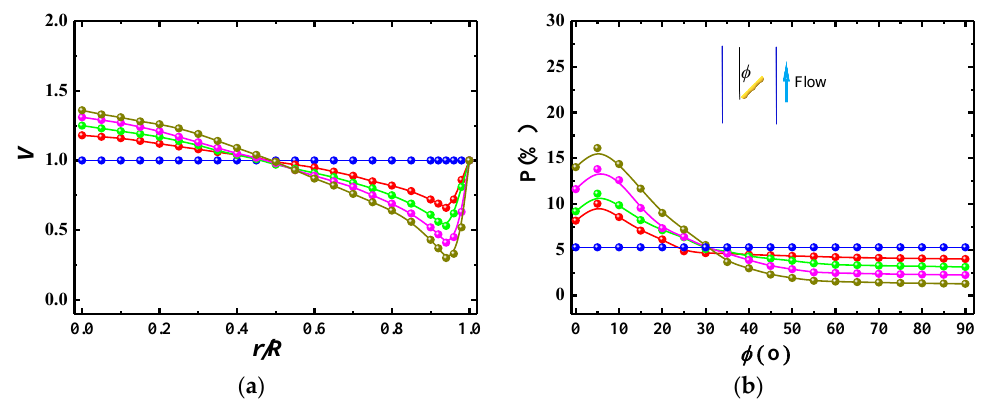
Figure 4. Distribution of ( a ) particle concentration and ( b ) particle orientation at different axial positions ( λ = 8, Re = 20,000, L/D = 200). ●: z/D = 0; ●: z/D = 50; ●: z /D = 100; ●: z/D = 150; ●: z/D = 200.